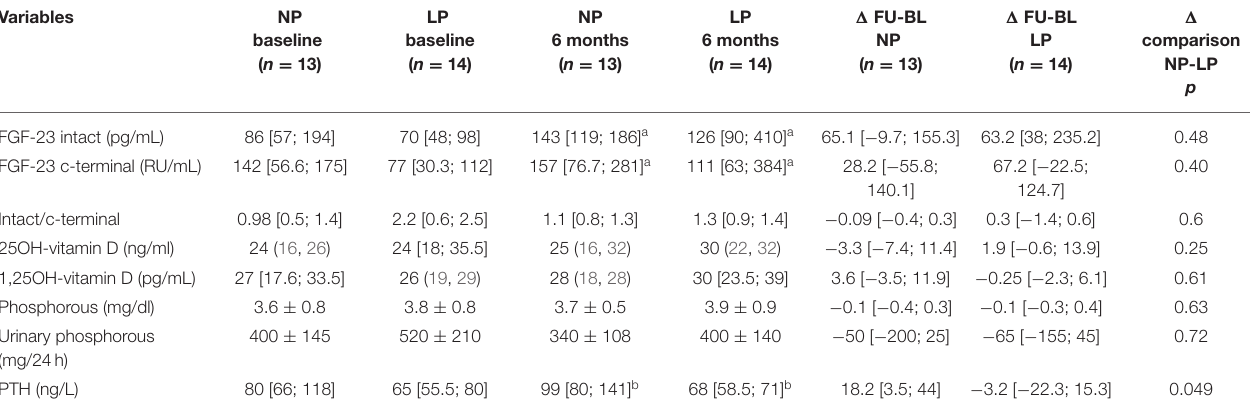
TABLE 5 | Assessment of calcium-phosphorous metabolism. Variables